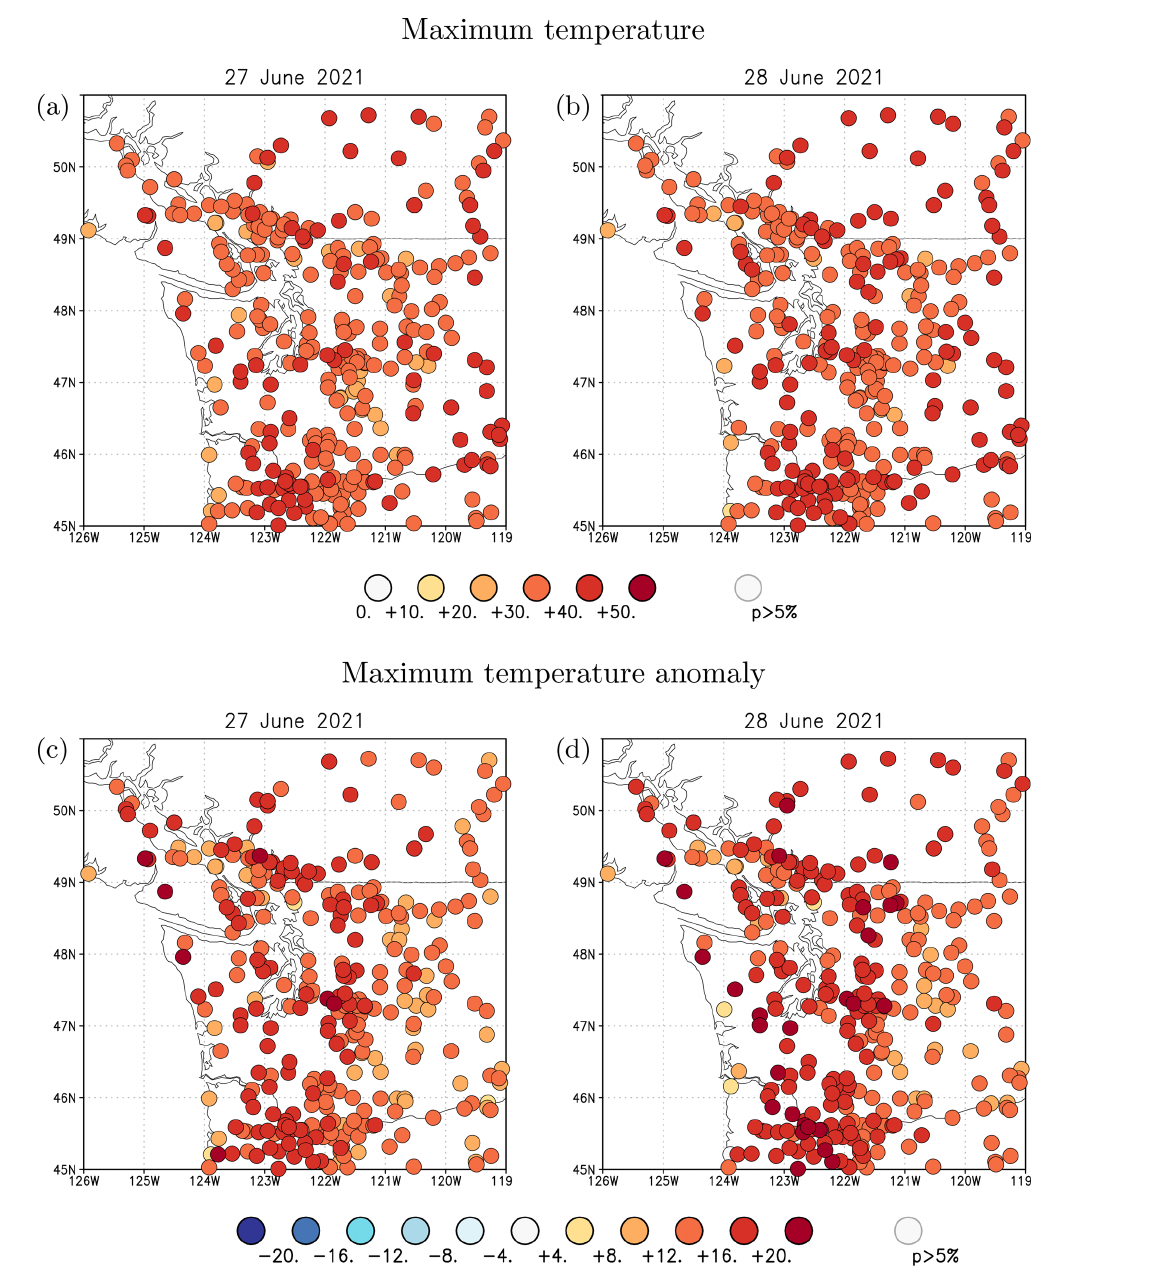
Figure 1. (a) Observed temperatures on 27 June 2021 and (b) 28 June 2021. (c, d) Same for anomalies relative to the climatological mean of the whole station records for these specific days of the year. Source: GHCND (Menne et al.,